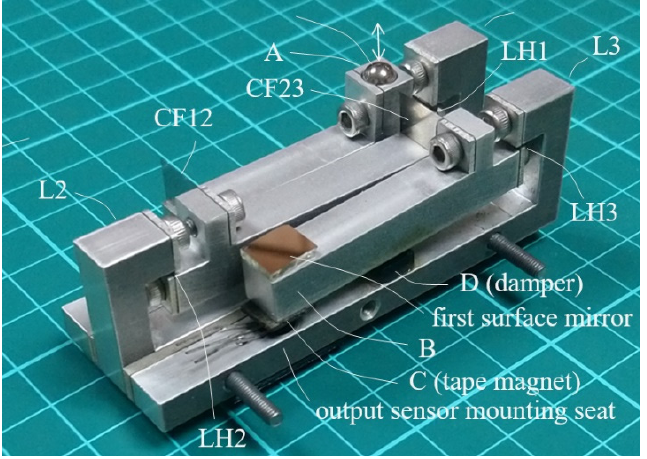
Figure 15. The proof-of-concept prototype, with an overall dimension of 82 mm × 28 mm × 24 mm.